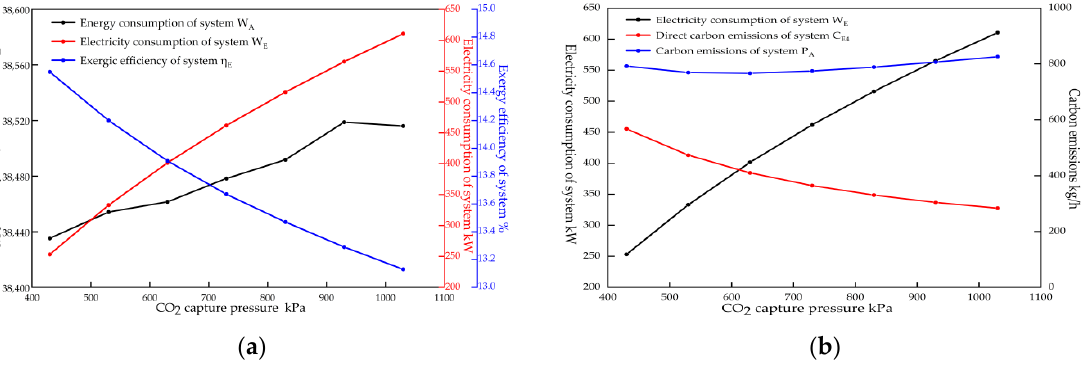
Figure 8. The effect of CO 2 capture pressure on system performance. ( a ): System energy consumption and exergy efficiency; ( b ): System electricity consumption and carbon emissions.